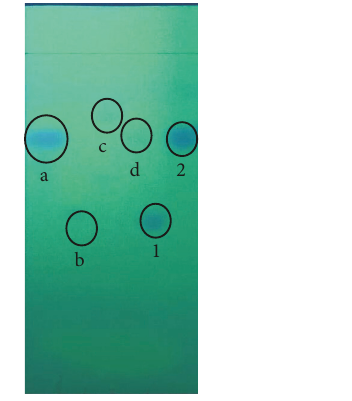
Figure 6: TLC analysis of herbal medicine samples: (a) sample a, (b) sample b, (c) sample c, (d) sample d; (1) allopurinol standard, (2) paracetamol